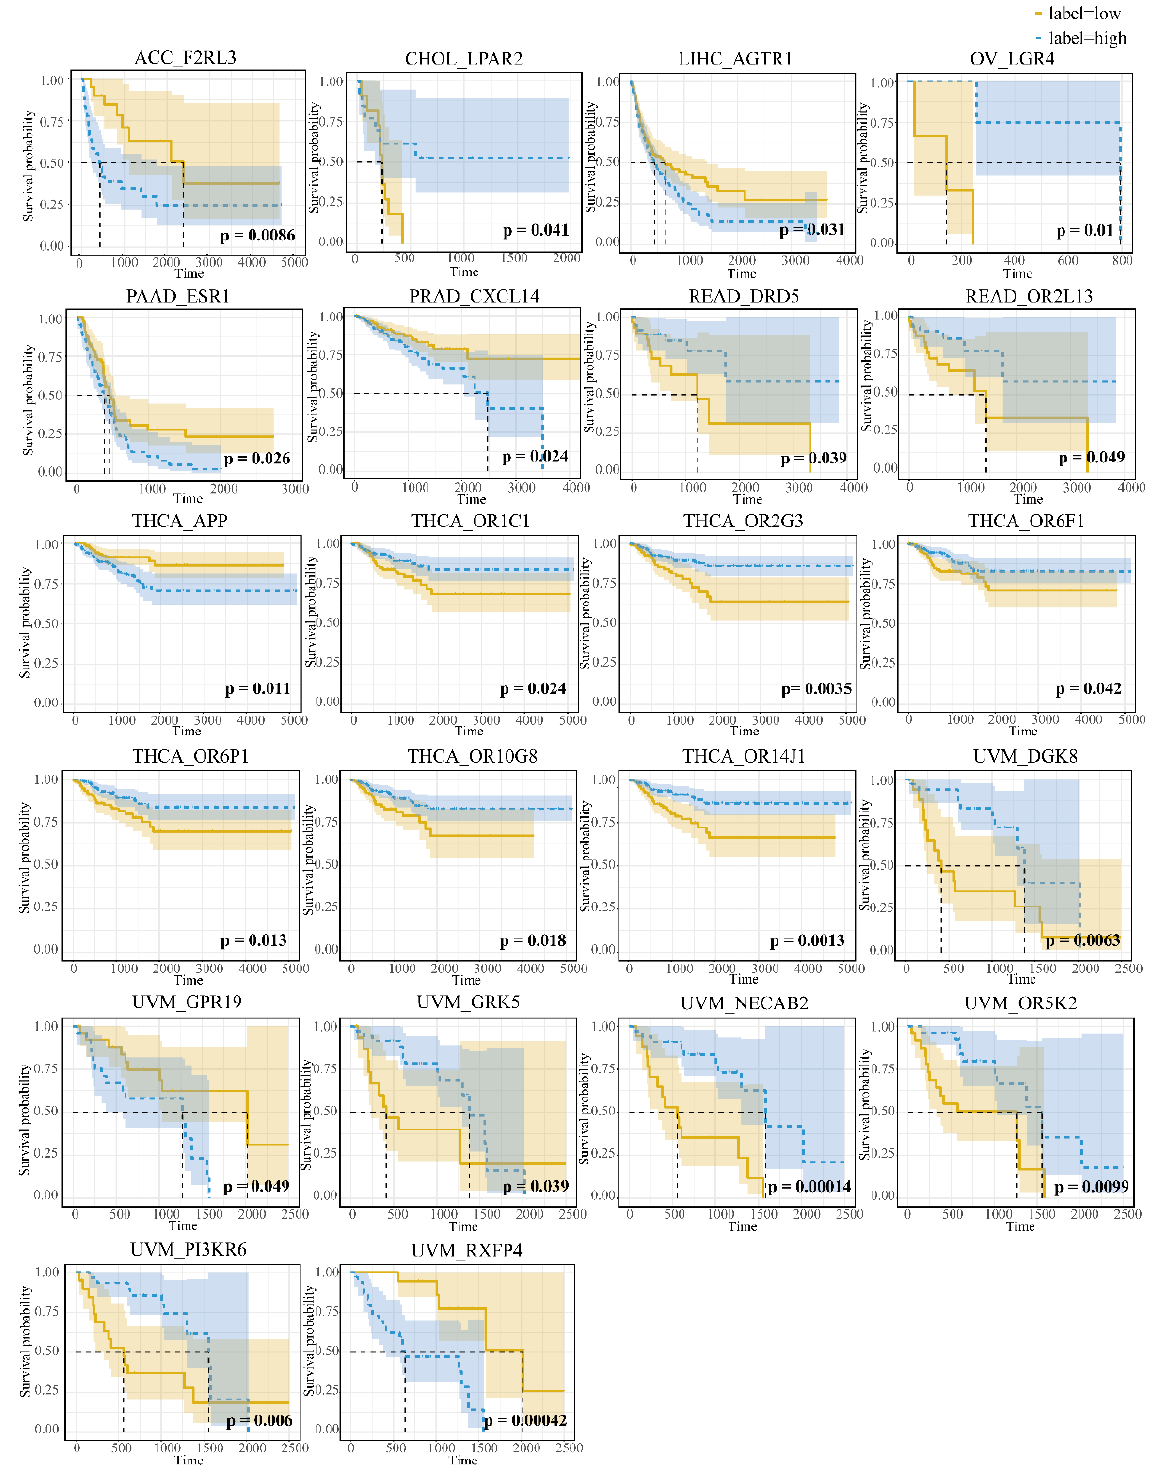
Figure 4. The survival curves of GRSDMs with significant related prognosis.